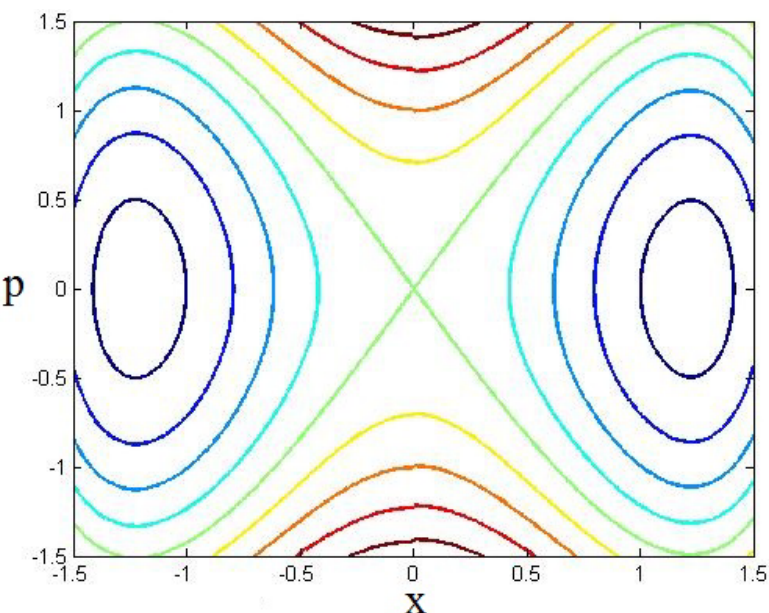
Figure 8. Phase portrait of the PDM Hamiltonian associated with double well potential for λ = 0.01.